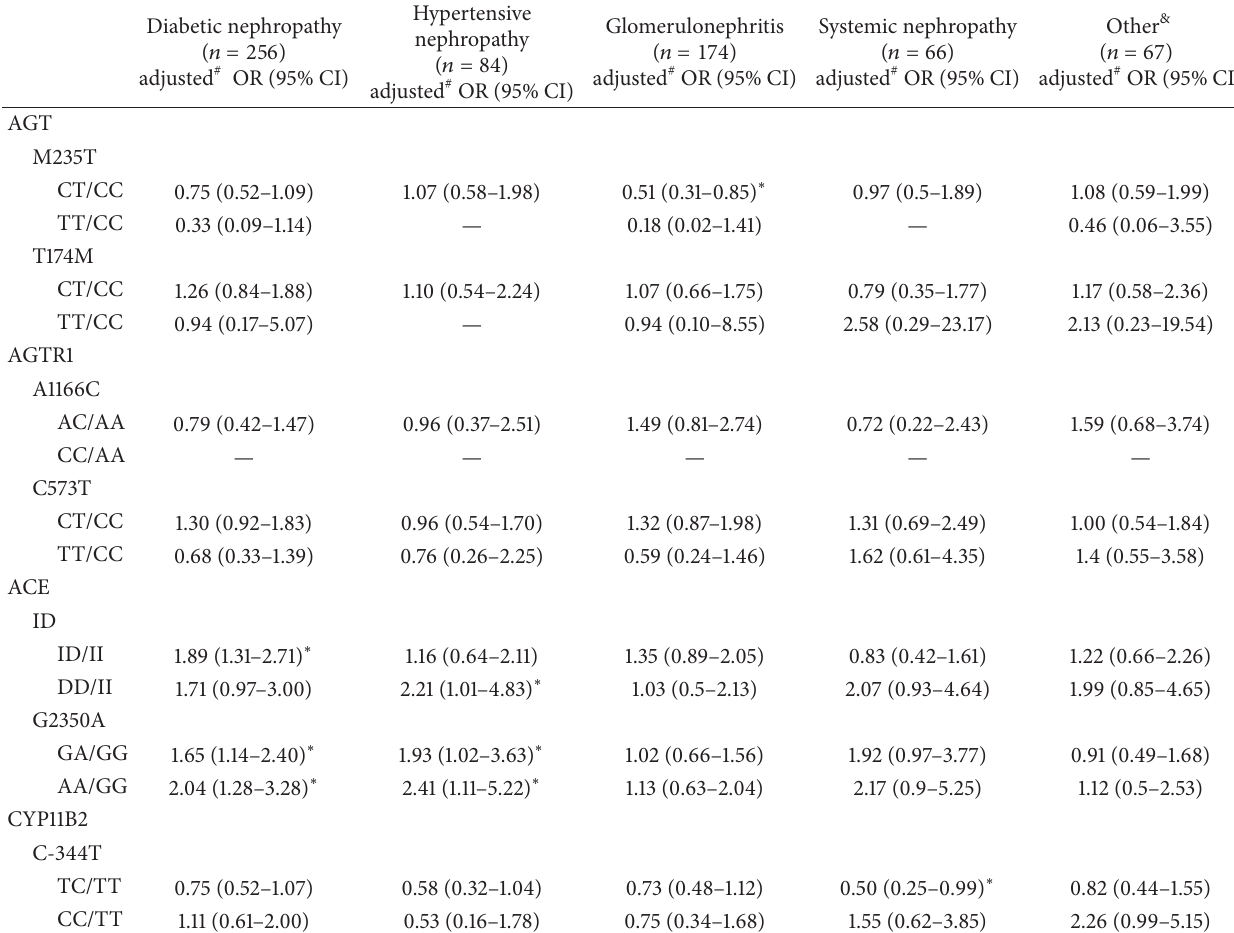
Table 3: AGT, AGTR1, ACE, and CYP11B2 gene polymorphisms with risk of different cause of ESRD.